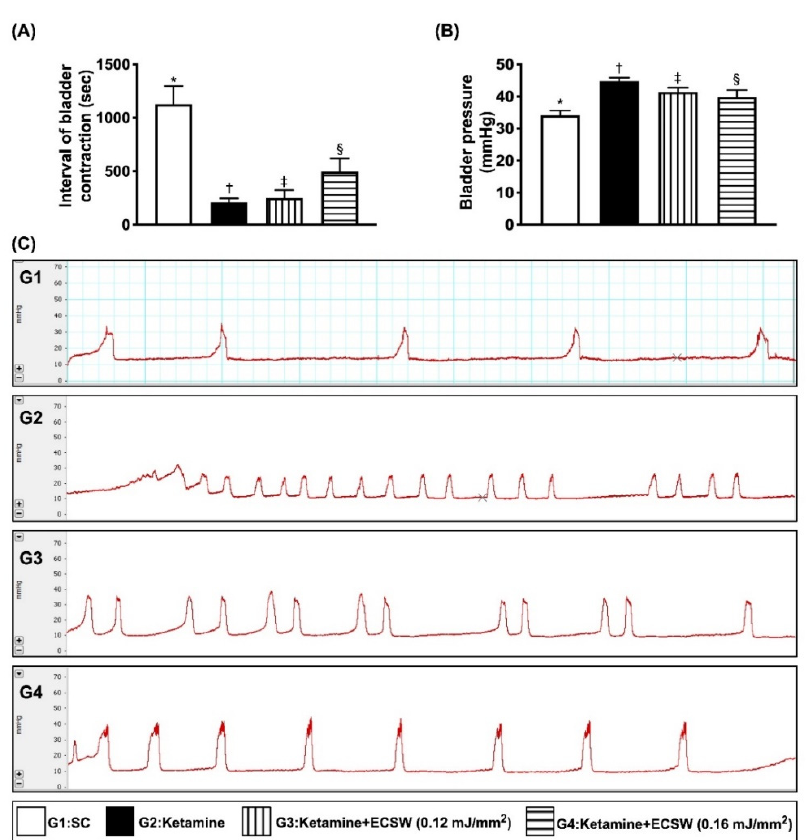
Figure 5. ECSW therapy inhibited ketamine-induced urine frequency, time interval of bladder contraction and bladder maximal pressure. ( A ) The time interval of urinary bladder contraction, * vs. other groups with different symbols (†, ‡, §), p < 0.0001. ( B ) Maximal urinary bladder pressure, * vs. other groups with different symbols (†, ‡, §), p < 0.0001. ( C ) Illustrating the time interval of urinary bladder contraction (i.e., the frequency) among the four groups. The frequency of urinary bladder contraction in G2 was remarkably increased as compared with G3 and G4 and more remarkably increased as compared with G1 (i.e., sham-control). All statistical analyses were performed by one-way ANOVA, followed by Bonferroni multiple comparison post hoc test ( n = 6 for each group). Symbols (*, †, ‡, §) indicate significance (at 0.05 level). ECSW = extracorporeal shock wave.